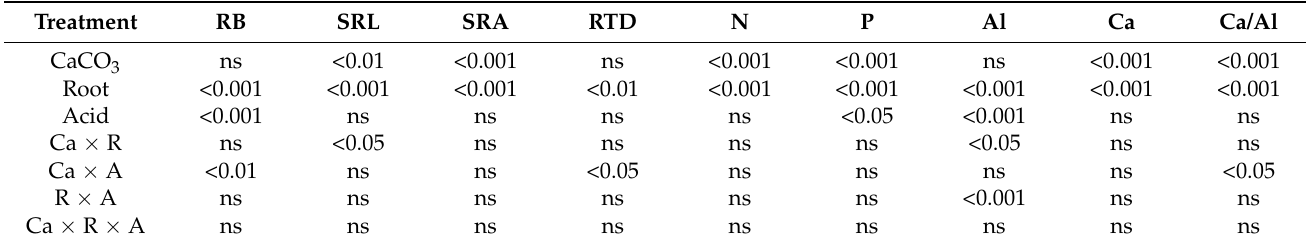
Table 2. Three-way ANOVA analysis for fine-root morphologies and nutrient concentrations among different soil acidification degrees (Acid), liming levels (CaCO 3 ), and fine root functional group (Root).